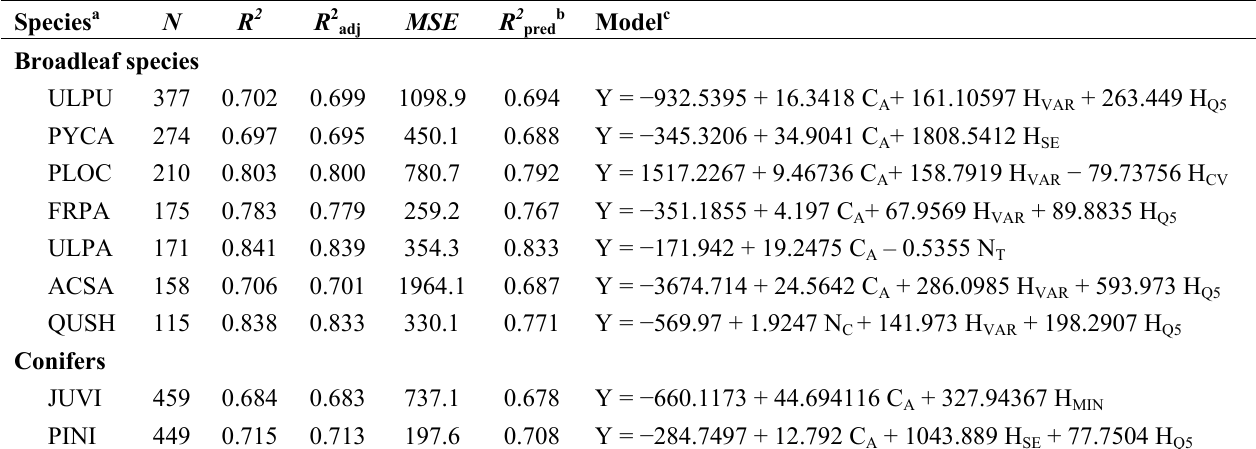
Table 11. Results of regression analysis of aboveground biomass (kg) of individual